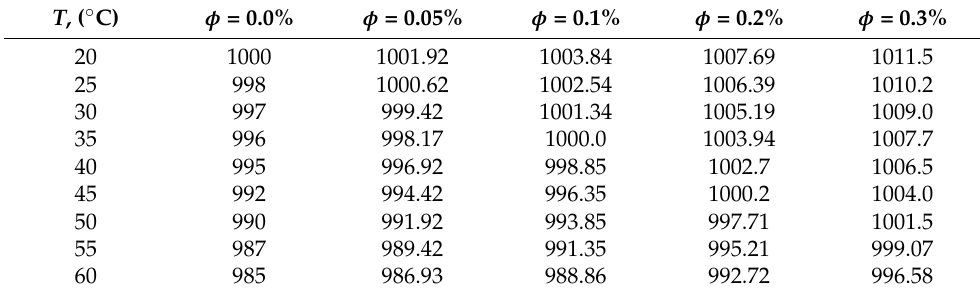
Table 4. Density of hybrid nanofluids.